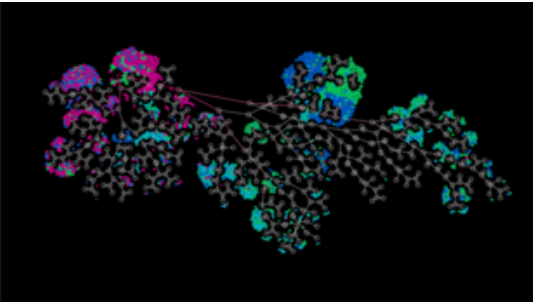
Figure 13 | Visualizations of a decision tree, a simple machine learning generated classifier with four prediction